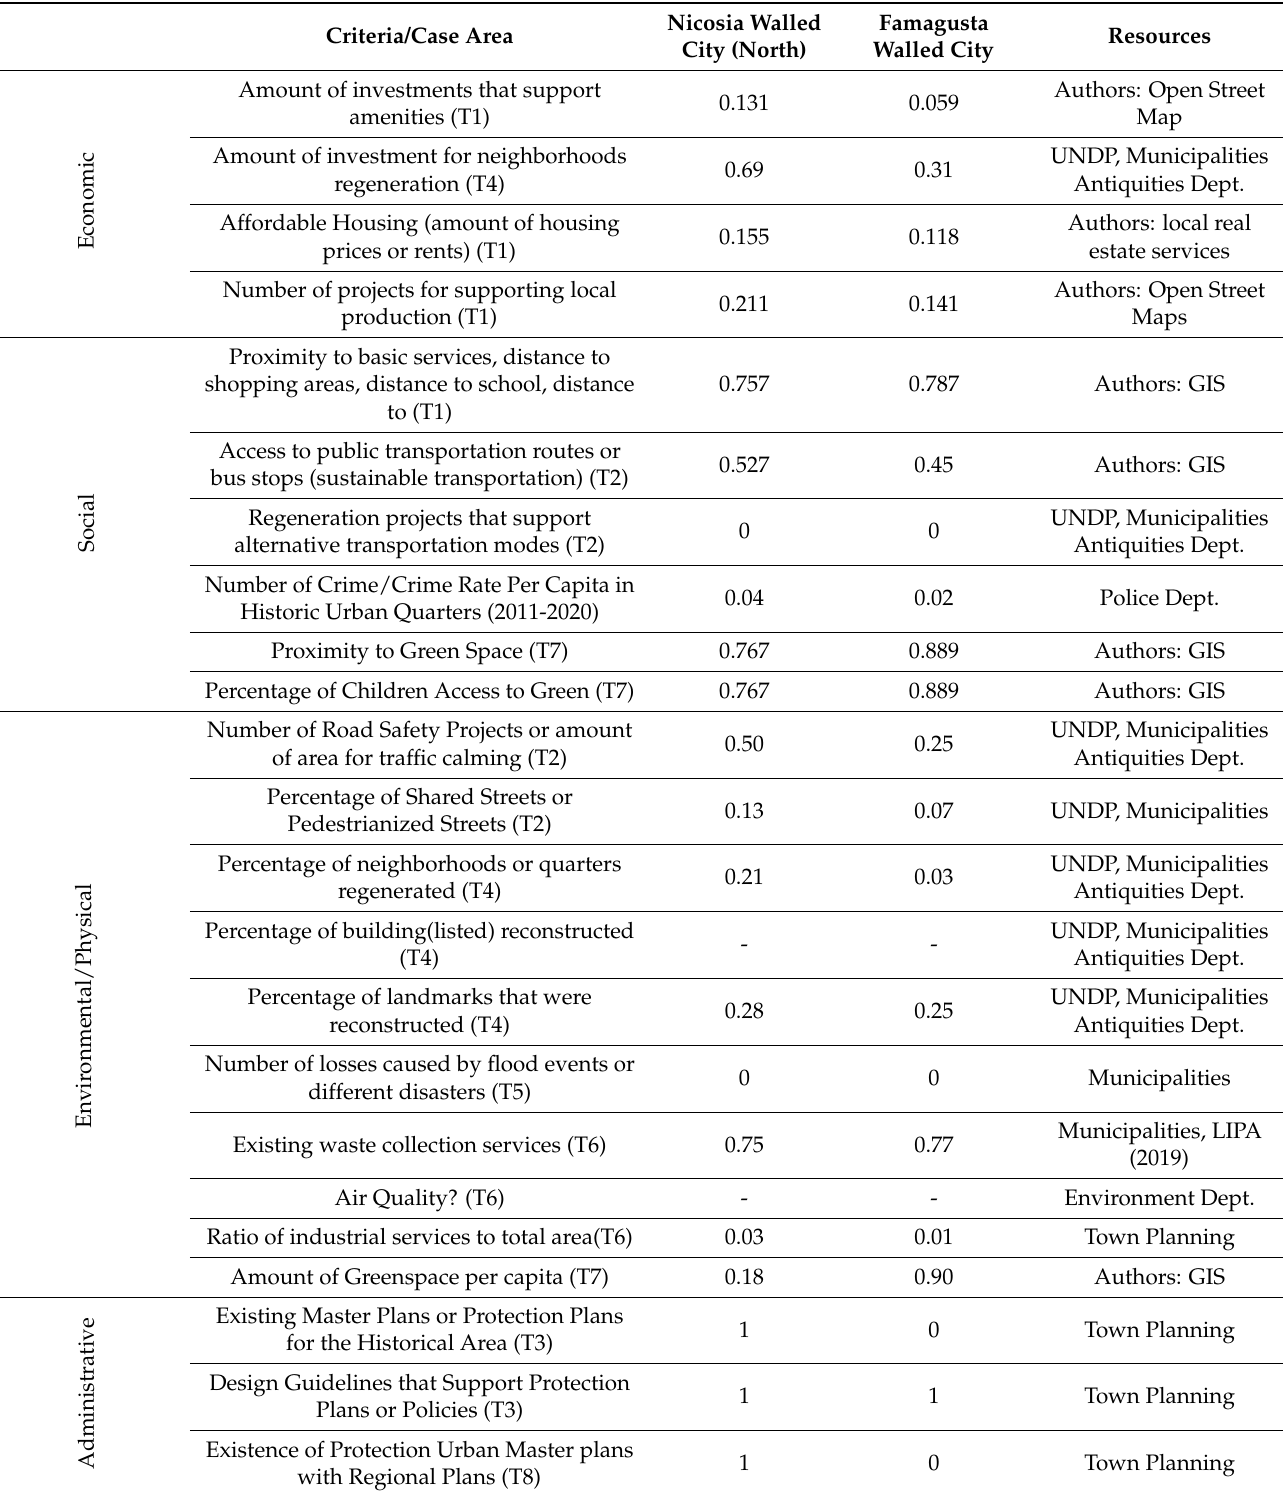
Table 3. Evaluation of the Criteria and Sub-Criteria for the case areas. Criteria/Case